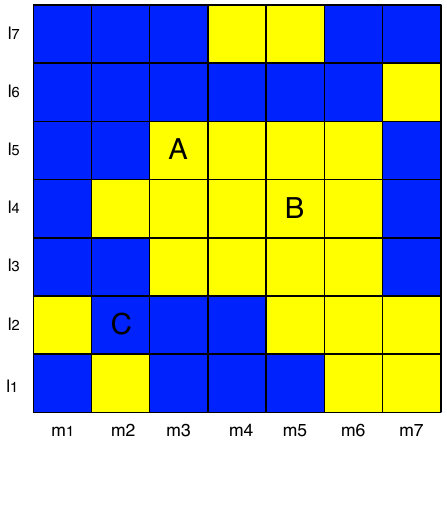
Figure 4. LTE Resource Blocks